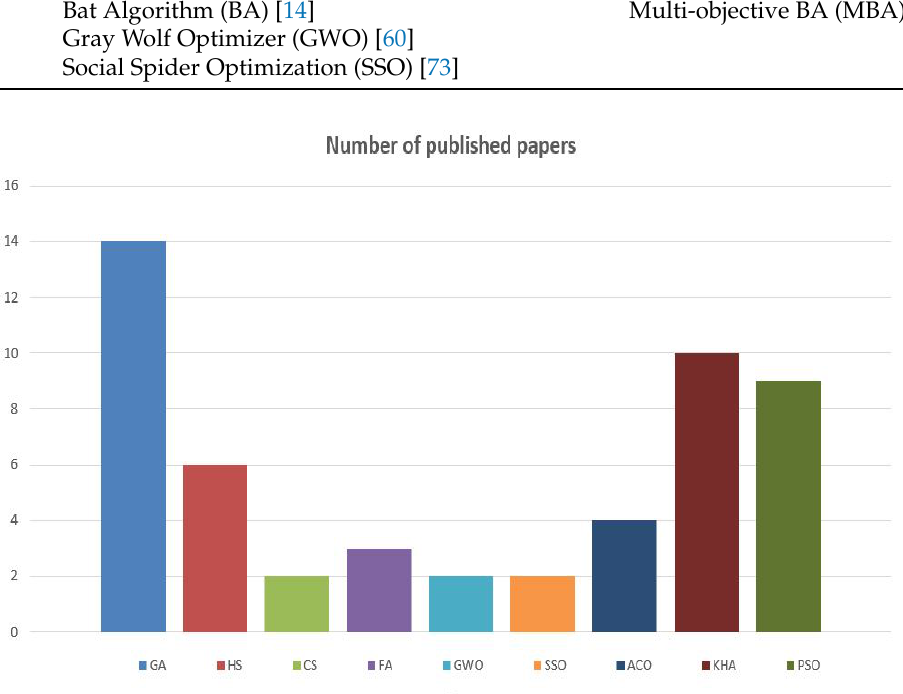
Figure 3. The number of published papers for the NI